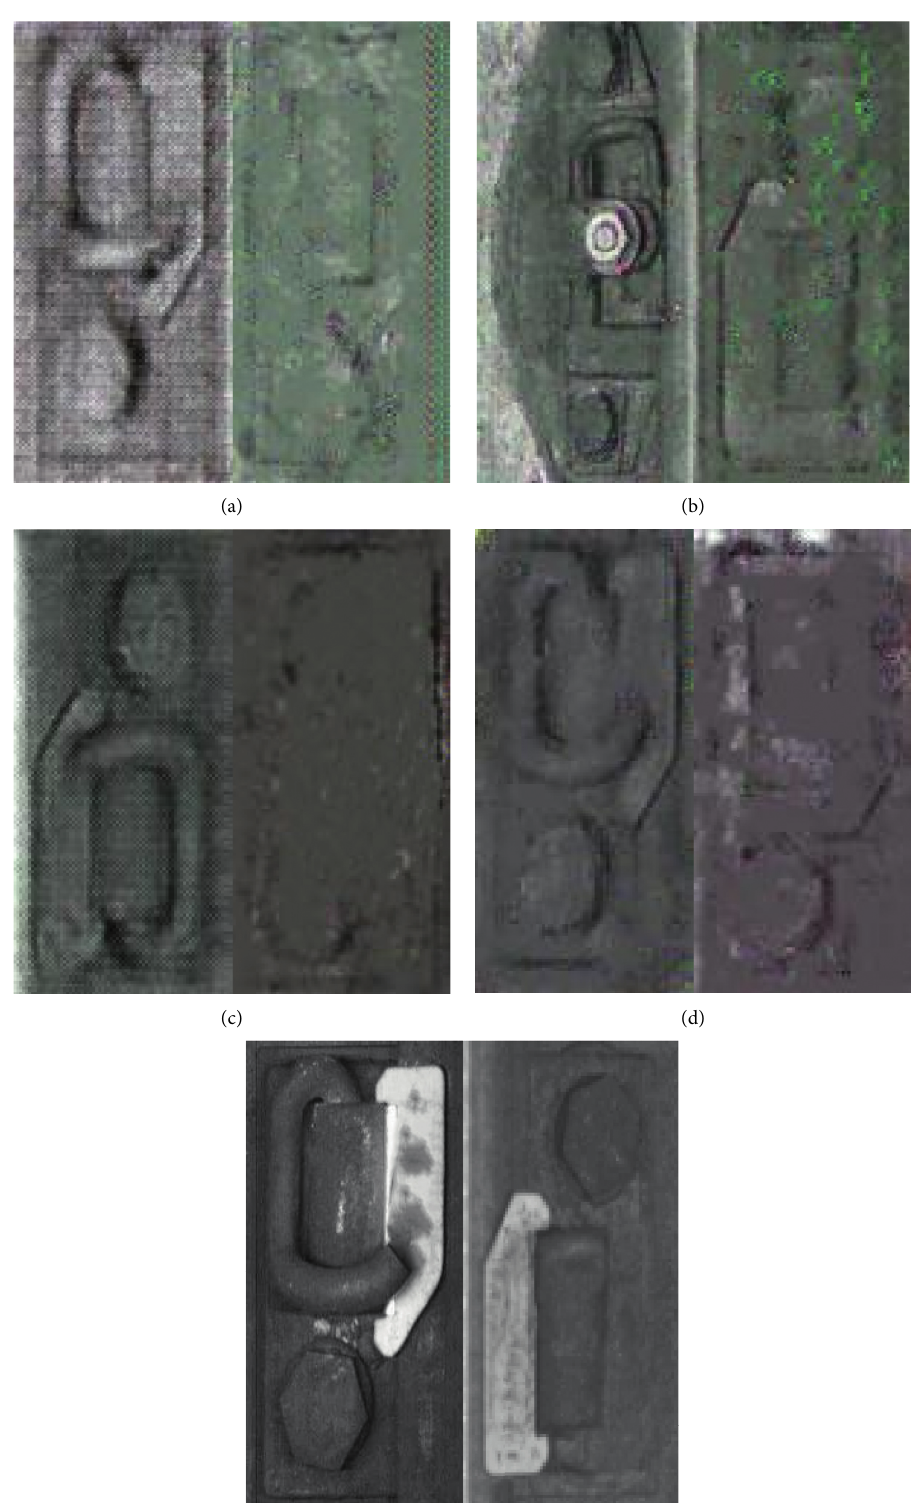
Figure 12: Generation of sample data in different training cycles. (a) 1000 epochs, (b) 1500 epochs, (c) 2000 epochs, (d) 2500 epochs, and (e) 3000